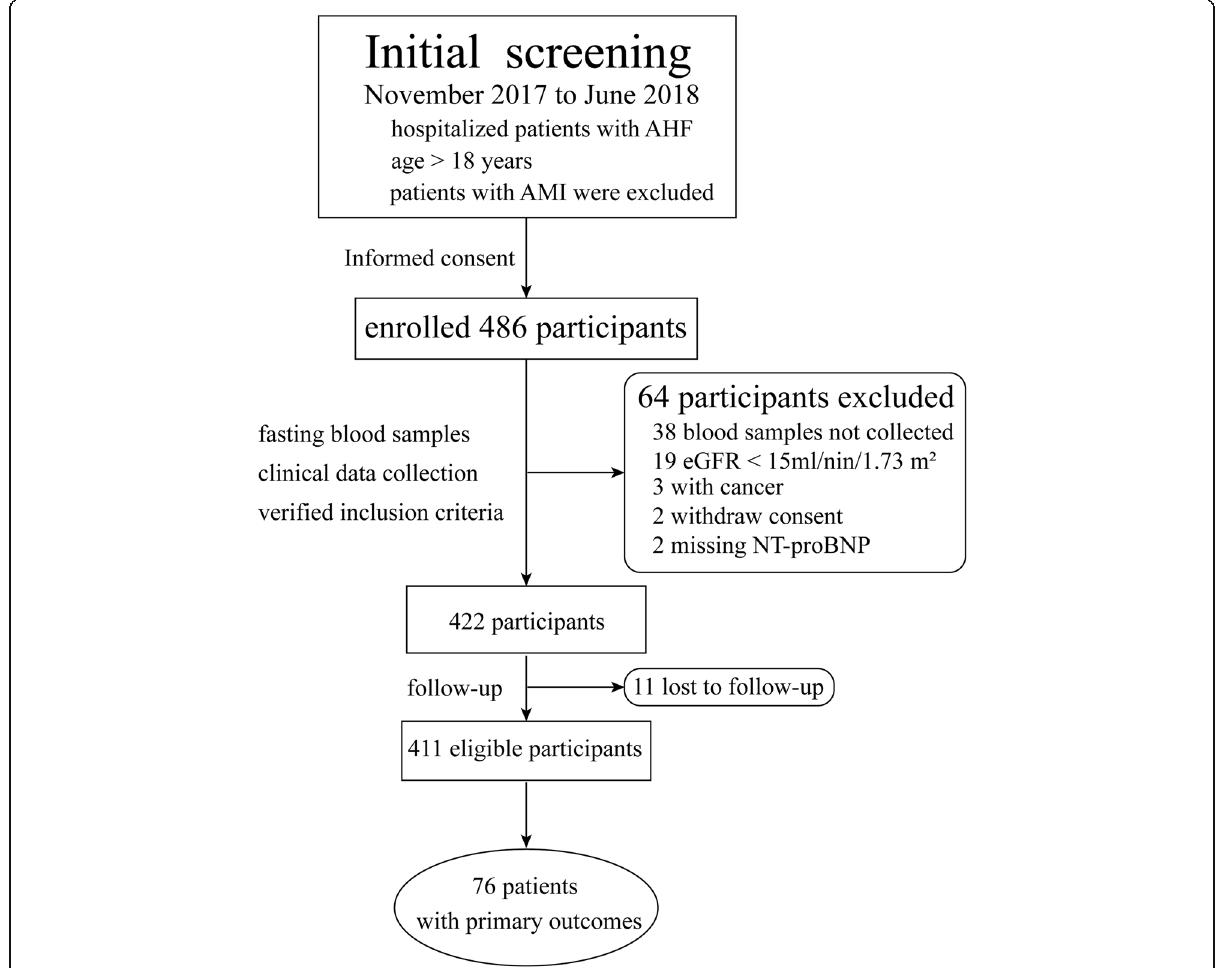
Fig. 1 Inclusion flow chart and outcomes for the AHF cohort. AHF: acute heart failure, AMI: acute myocardial infarction, 2OG: 2-oxoglutarate, eGFR: estimated glomerular filtration